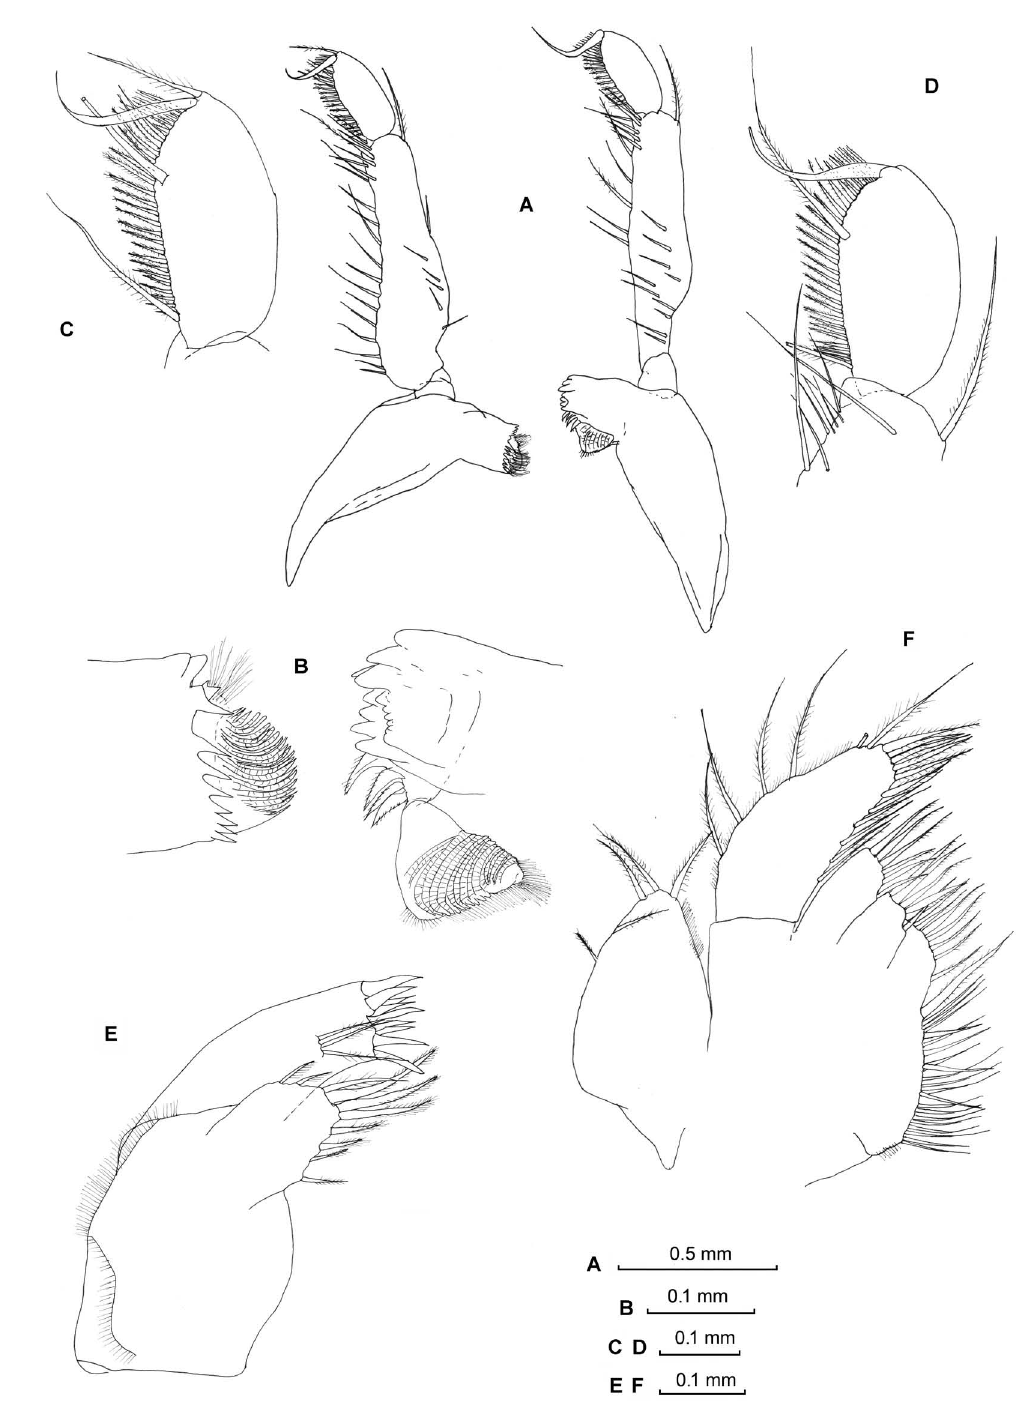
Fig . 2. – Dactylamblyops corberai n. sp.: A, mandibles; B, cutting edges of mandibles; C, terminal segment of right mandibular palp; D, terminal segment of left mandibular palp; E, maxillule; F, maxilla. A-E, holotype, mature male; F, paratype, mature male TL 7.0